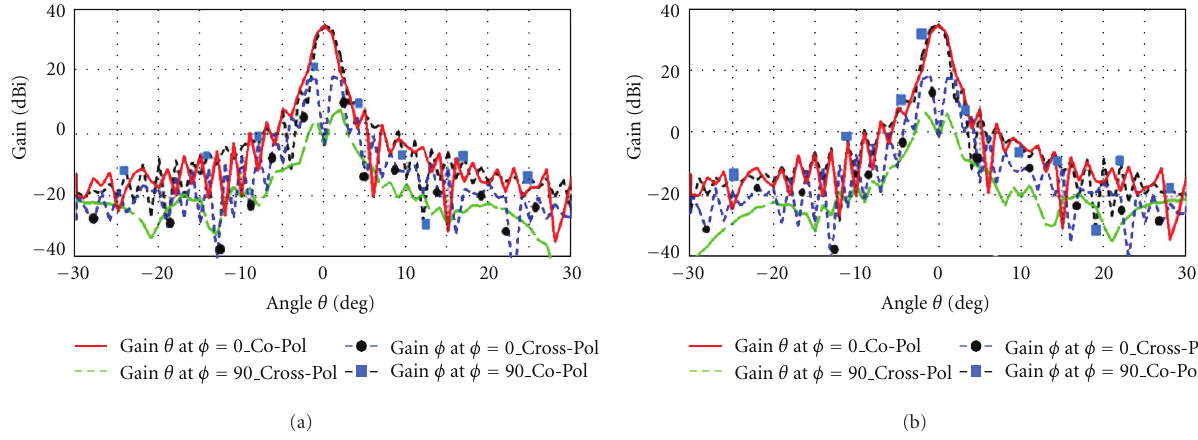
Figure 15: Reflector antenna radiation patterns at 7.73 GHz with the feedhorn mode combination of TE 11 (50%) + TE 21 (50%) for (a) +90 ◦ and (b) − 90 ◦ phase values.